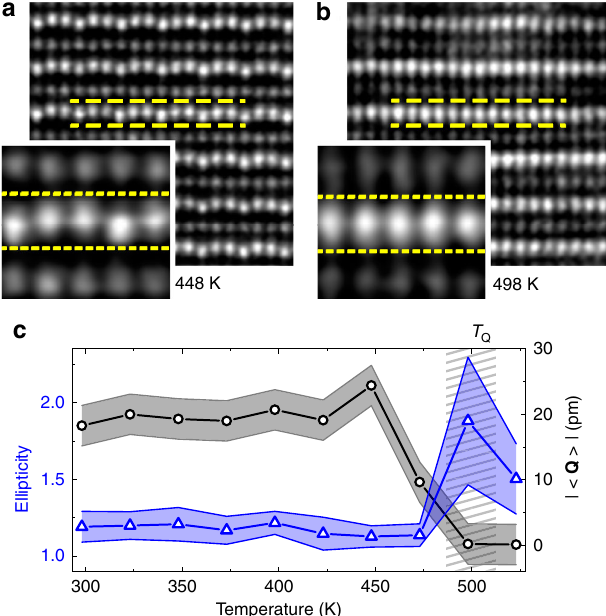
Fig. 4 Real-space observation of the order – disorder-type phase transition. a , b The dashed yellow lines highlight the agreement between discrete displacement amplitudes in the ferroelectric phase ( a ) and the spread of the Y peaks in the paraelectric phase ( b ) in the 10-unit-cell YMnO 3 thin fi lm. An order – disorder character of the structural phase transition is revealed, where loss of long-range order (| 〈 Q 〉 | → 0) is accompanied by the observation of elliptic Y atomic peaks due to superposition of a continuum of displacement states. c The average of Q (black circles) and average Y atomic peak ellipticity (blue triangles) from HAADF-STEM plotted as function of temperature for the same sample as in a , b . The increase of ellipticity arises directly as T Q (indicated by the gray hatched area) is crossed. The error bars for | 〈 Q 〉 | correspond to the estimated experimental error in determining Q during the in situ heating experiment. The error bars of the ellipticity are given by the standard deviation.